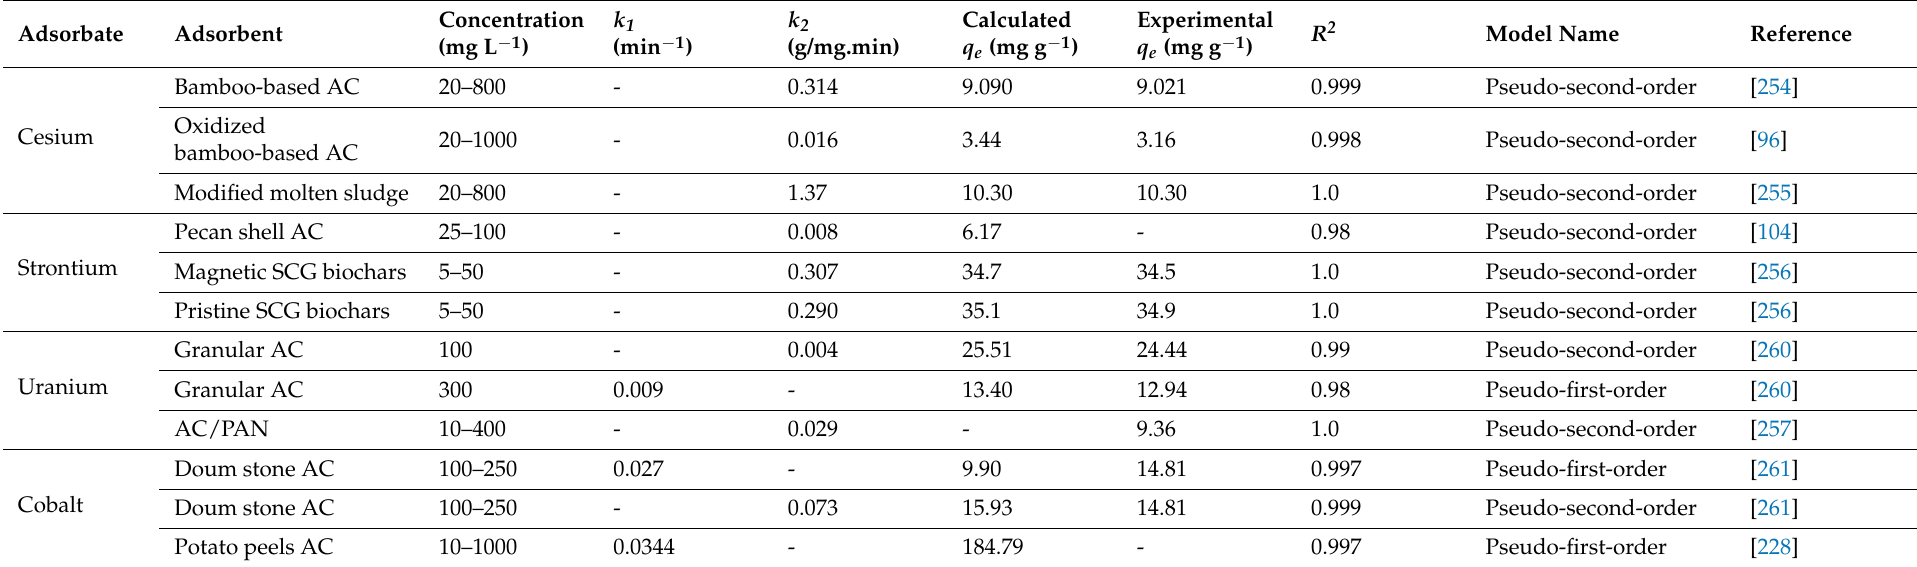
Table 10. Summary of fitted adsorption kinetics model parameter’s value of several